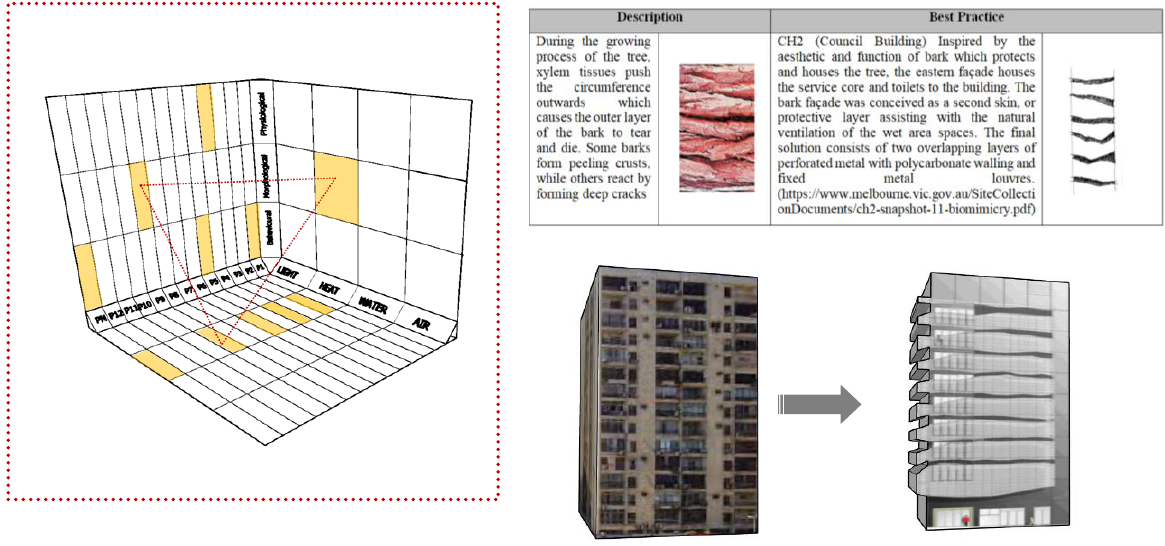
Figure 13: Example to Utilizing the use of tree bark strategy in renovating residential building for heat regulation on the morphological